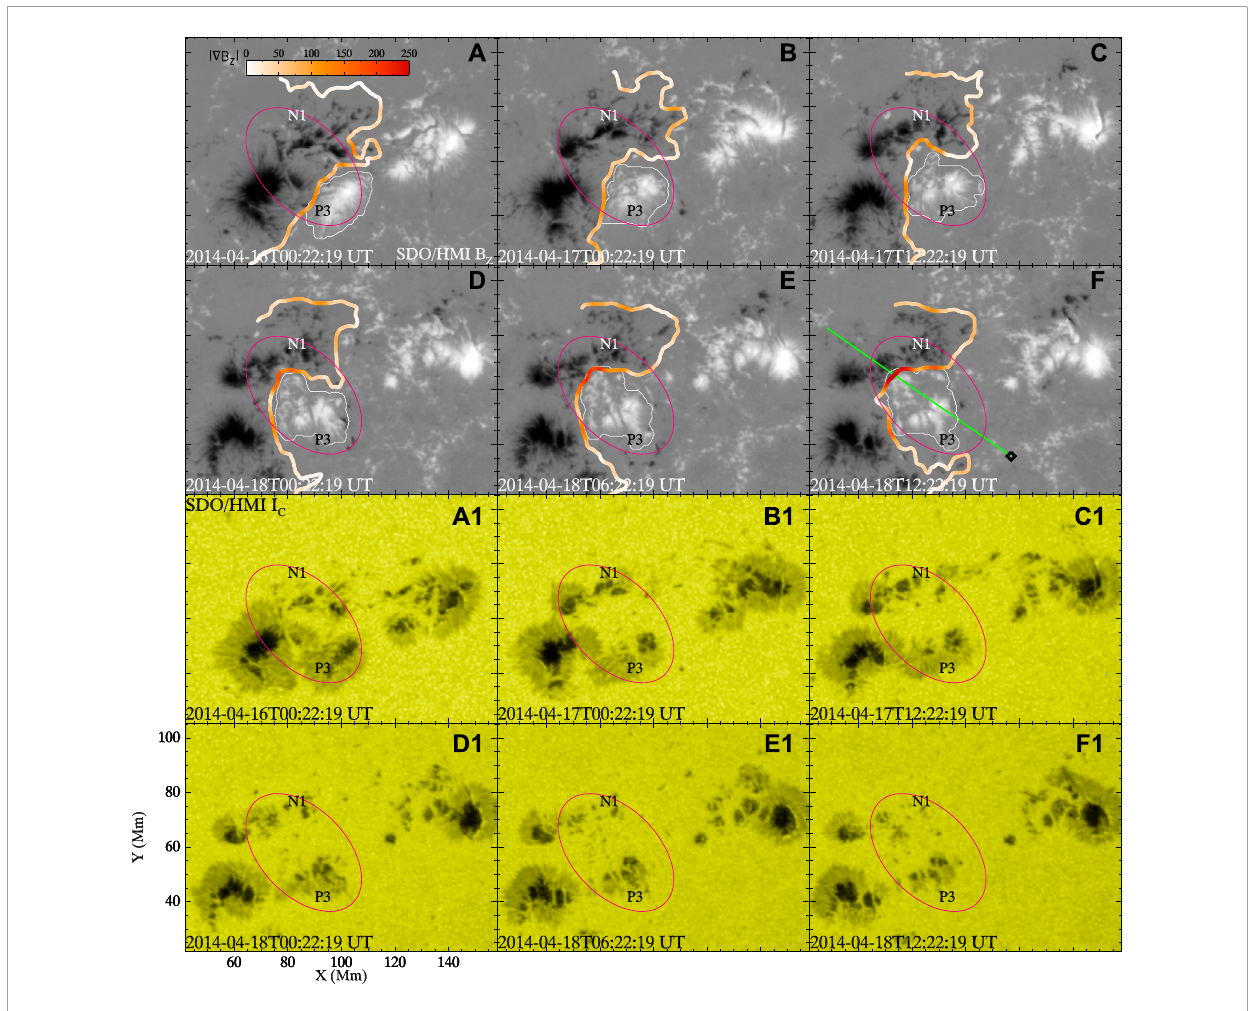
FIGURE 3 Evolution of the positive polarity P3. (A–F) Snapshots of the B z magnetograms zoomed on the polarities P3 and N1. The white contours outline the boundary of P3, within which the magnetic flux of P3 is calculated. The green line in panel (F) indicates the slice (taking the black diamond symbol as the start point) used to generate the time–distance plot of B z in Figure 4A . (A1–F1) Continuum intensity images corresponding to the B z maps. The magenta ellipse in each panel marks the interface region of the polarities P3 and N1. The colored curves are the PILs at each moment, the color of which is coded by the gradient of B z ( ▿ B z , in unit of G Mm −1 ) across the PIL. An associated animation ( Supplementary Video S2 ) is available